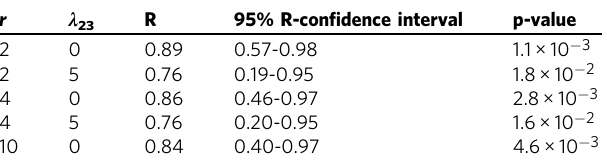
Table 1 Linear fi ts. Parameters associated with the linear fi ts between the wave occurrence rate and Mercury ’ s heliocentric distance, for different wave selection criteria. From left to right, r , λ 23 , the linear correlation factor (R), the 95% con fi dence interval and the p-value associated with the linear fi ts shown in Fig. 3. r is a factor associated with the intensity of magnetic fi eld power spectral density at the wave frequency range of interest, and λ 23 constitutes a threshold for the intermediate to minimum eigenvalue ratio associated with Minimum Variance Analysis. The reader is referred to Eqs. (1) – (3) for a strict de fi